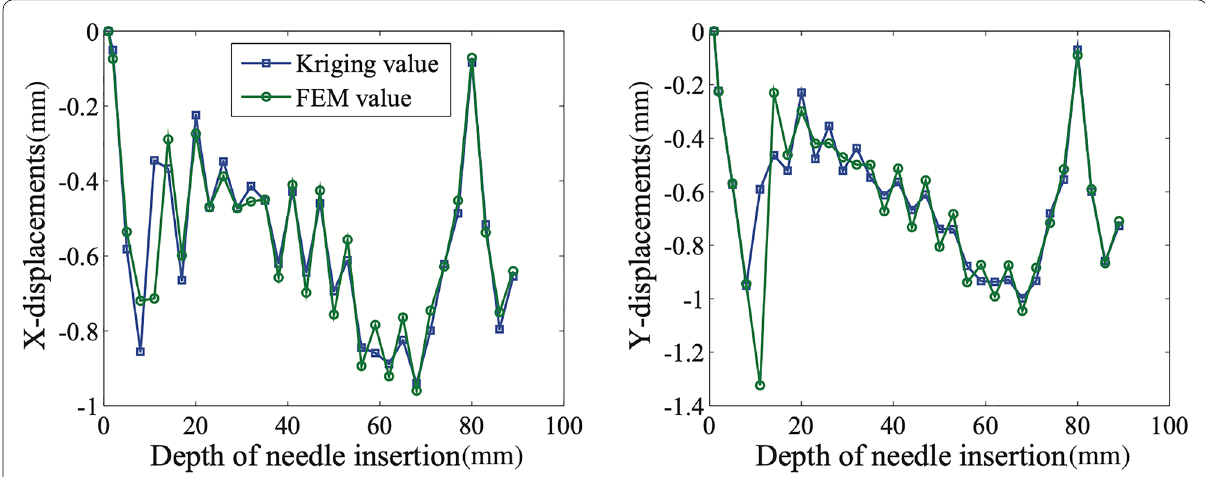
Figure 7 Kriging predictions for insertion depth-tissue displacement curve